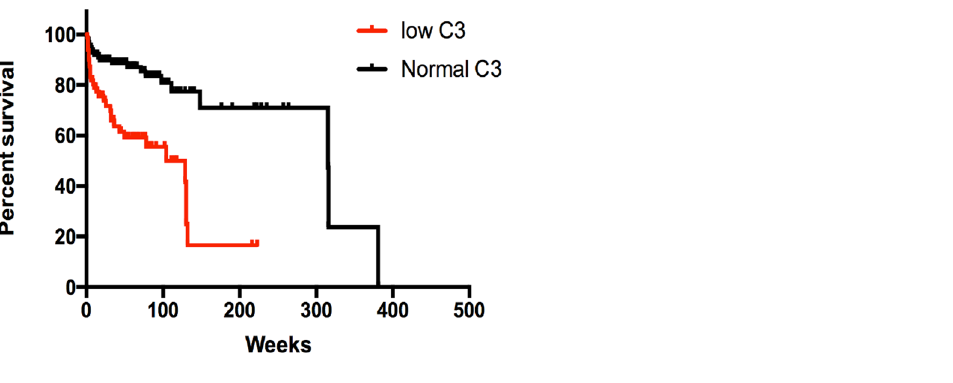
Figure 2. Renal survival according to serum C3